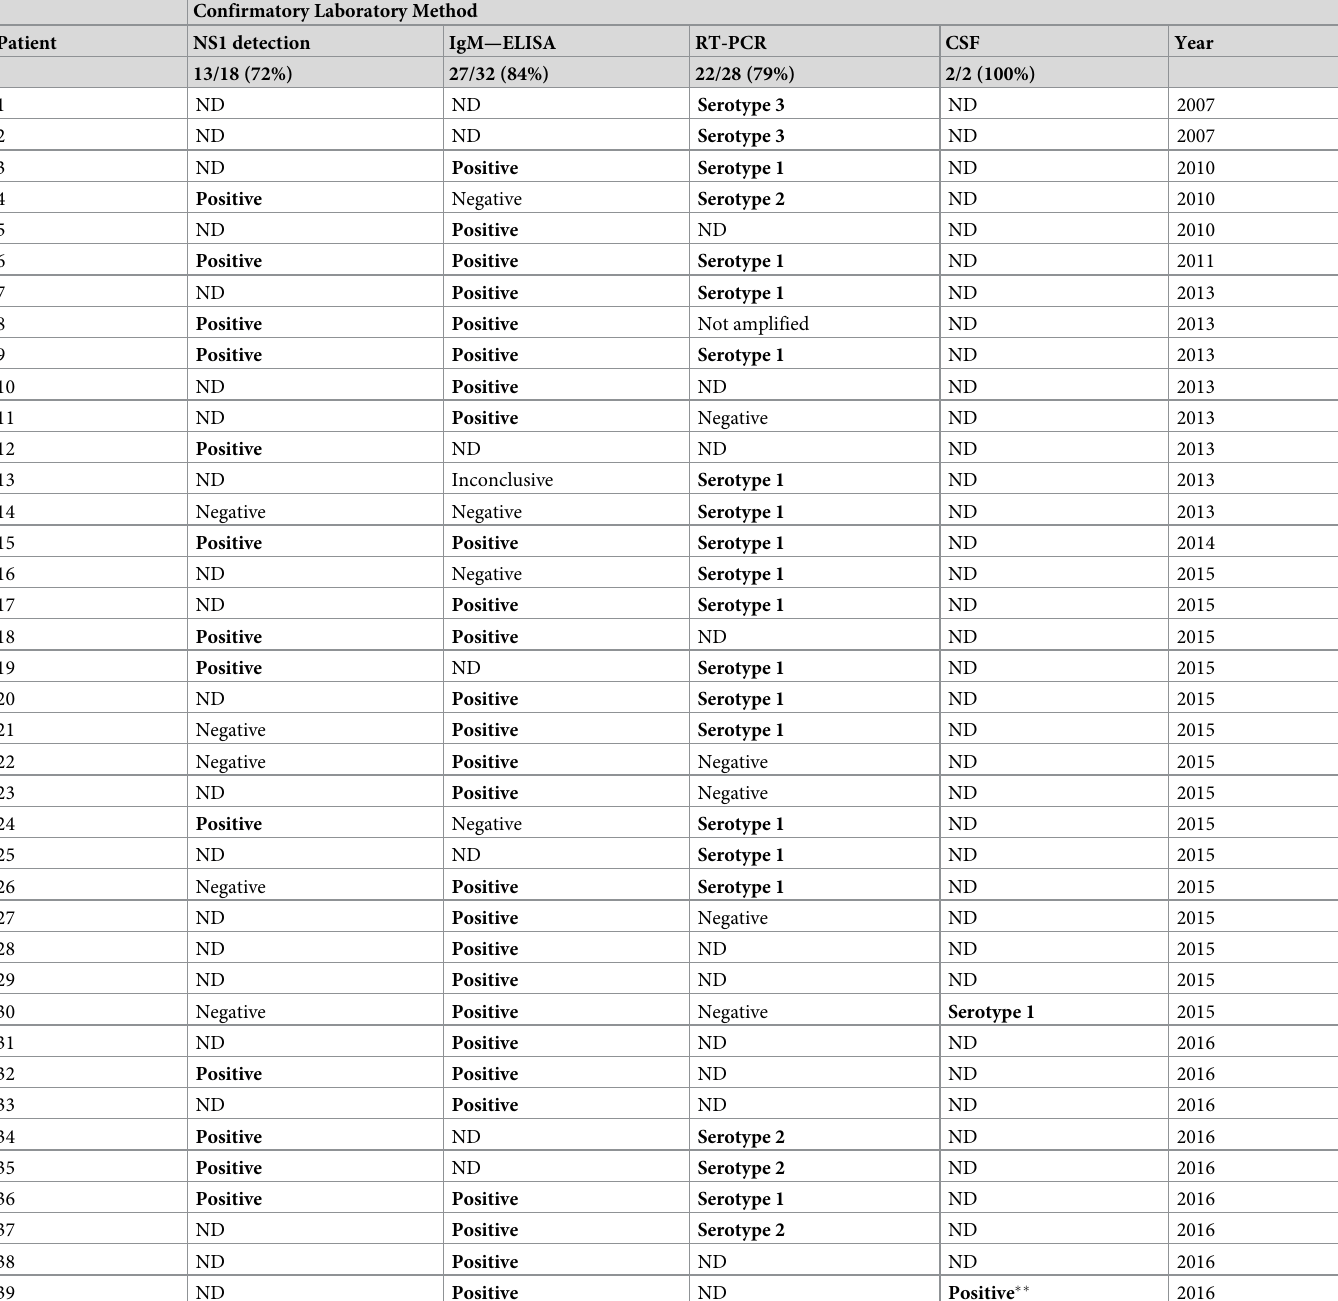
Table 3. Confirmatory diagnosis of dengue in each KTx